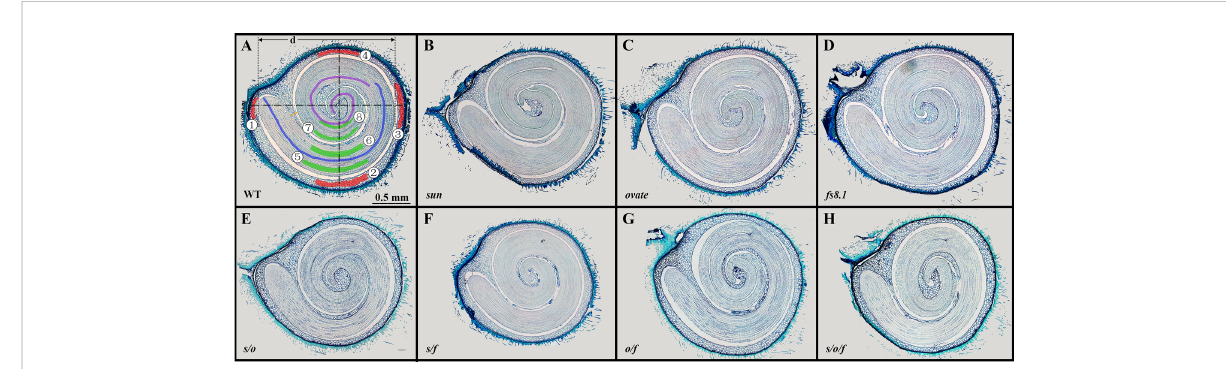
FIGURE 1 Paraf fi n sections of mature seeds of NILs WT (A) , sun (B) , ovate (C) , fs8.1 (D) , s/o (E) , s/f (F) , o/f (G) and s/o/f (H) . Detailed measurement methods are described in materials and